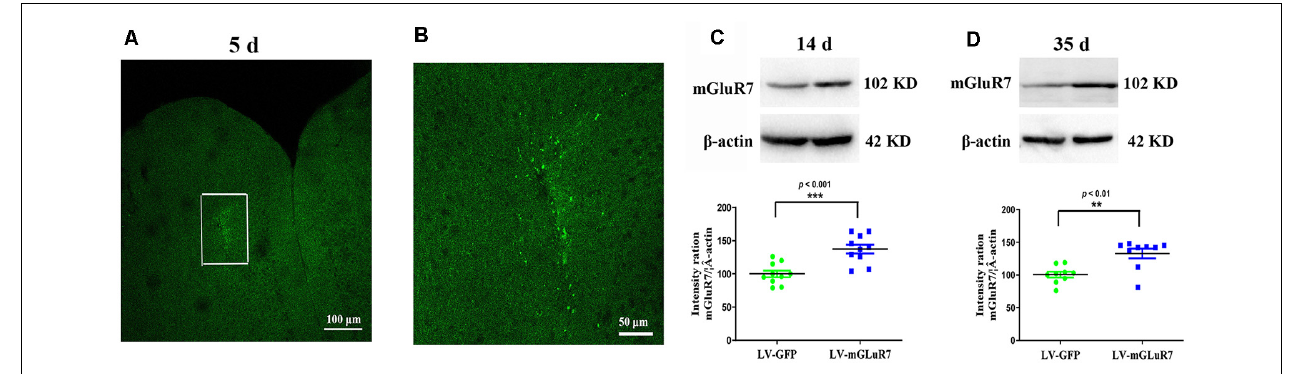
FIGURE 2 | Confirmation of mGluR7 overexpression in a mouse model of autism spectrum disorder (ASD). (A,B) GFP expression in the PFC of VPA-exposed mice was detected on day 5 post-LV injection. The region outlined in white in (A) is shown at a higher magnification in (B) . (C,D) mGluR7 protein levels were measured in mGluR7-overexpressing VPA-treated mice on days 14 and 45 post-LV injections. Normalized intensity bands for mGluR7 are presented. Lane 1, LV-GFP-exposed group; Lane 2, LV-mGluR7-treated group. n = 6 mice in each group. *** p < 0.001, ** p < 0.01. Student’s t -test. Results are shown as mean ±